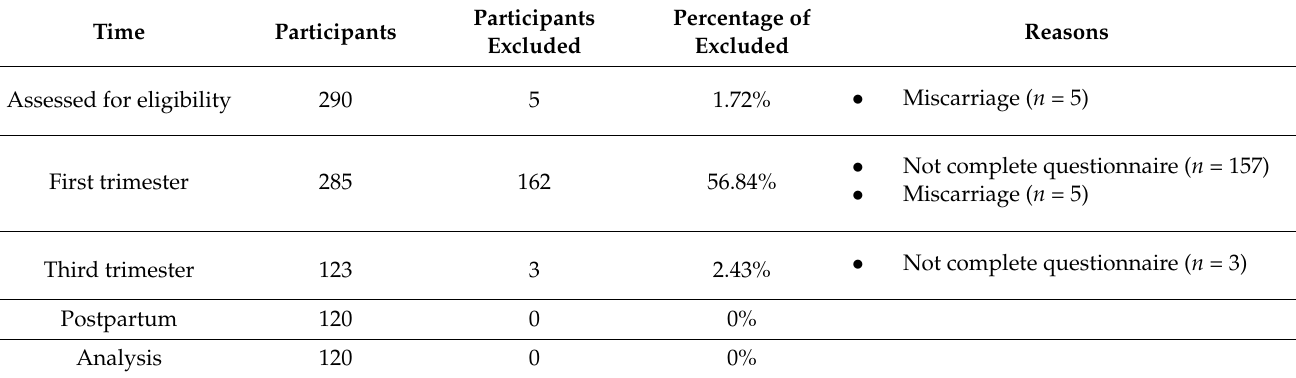
Table 1. Research design